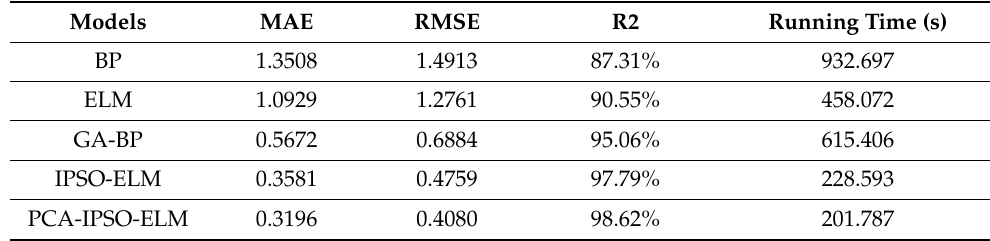
Table 8. Prediction model performance